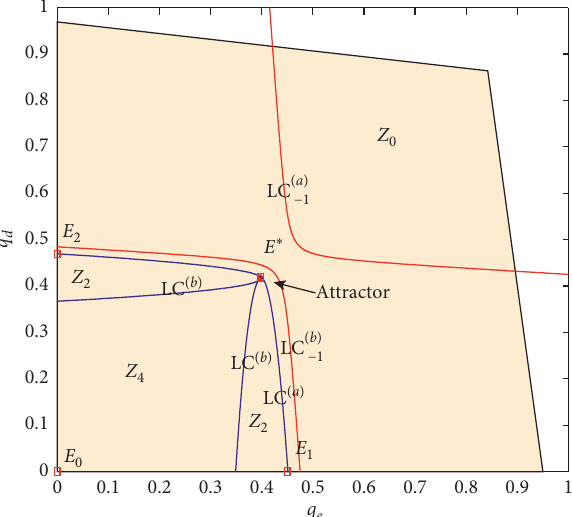
Figure 7: Attractor (red dot) and basin of attraction (yellow region), with β